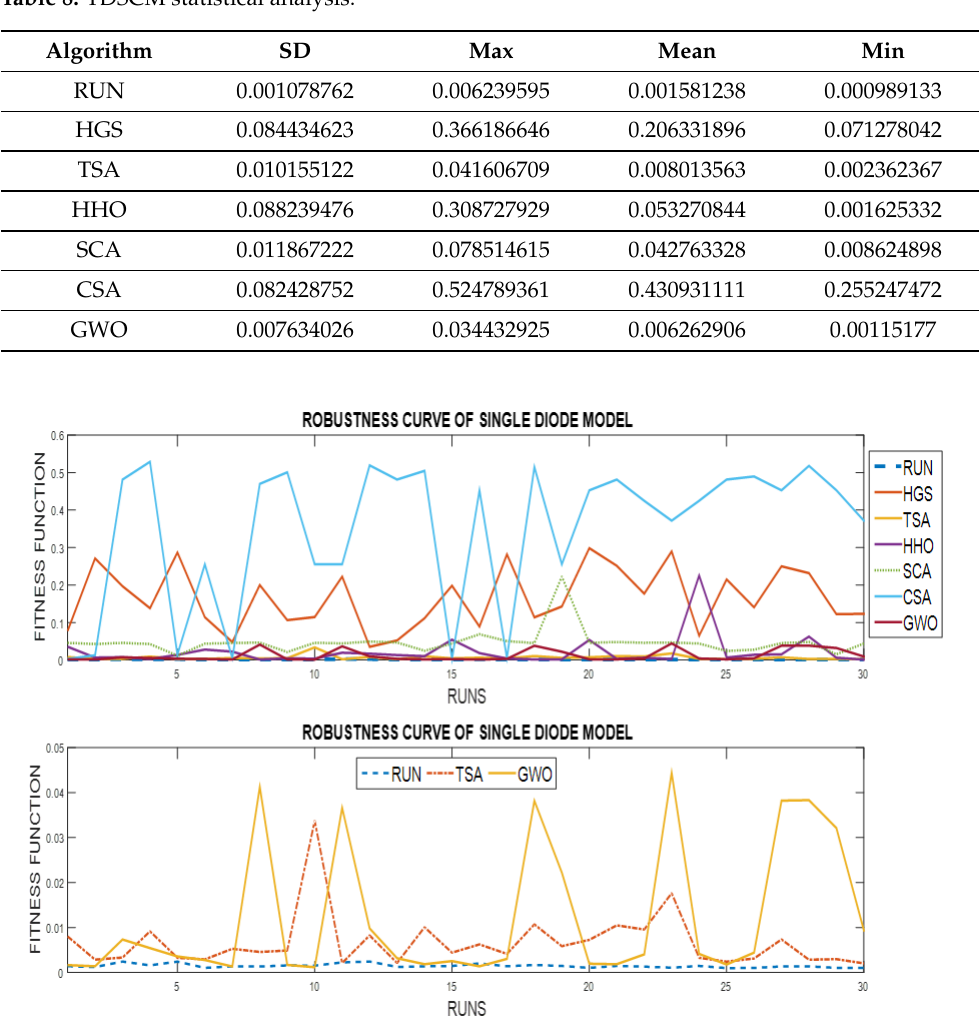
Table 8. TDSCM statistical analysis.